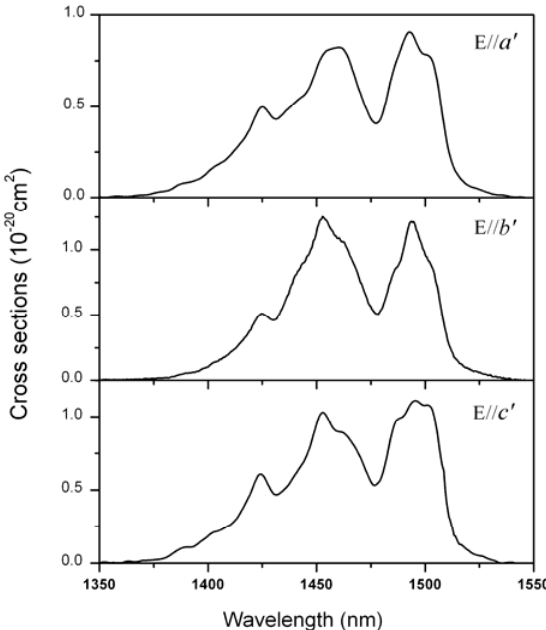
Figure 4. Polarized emission cross-sections of Tm 3+ :Li 3 H → 3 F transition around 1.5 μ 4 4